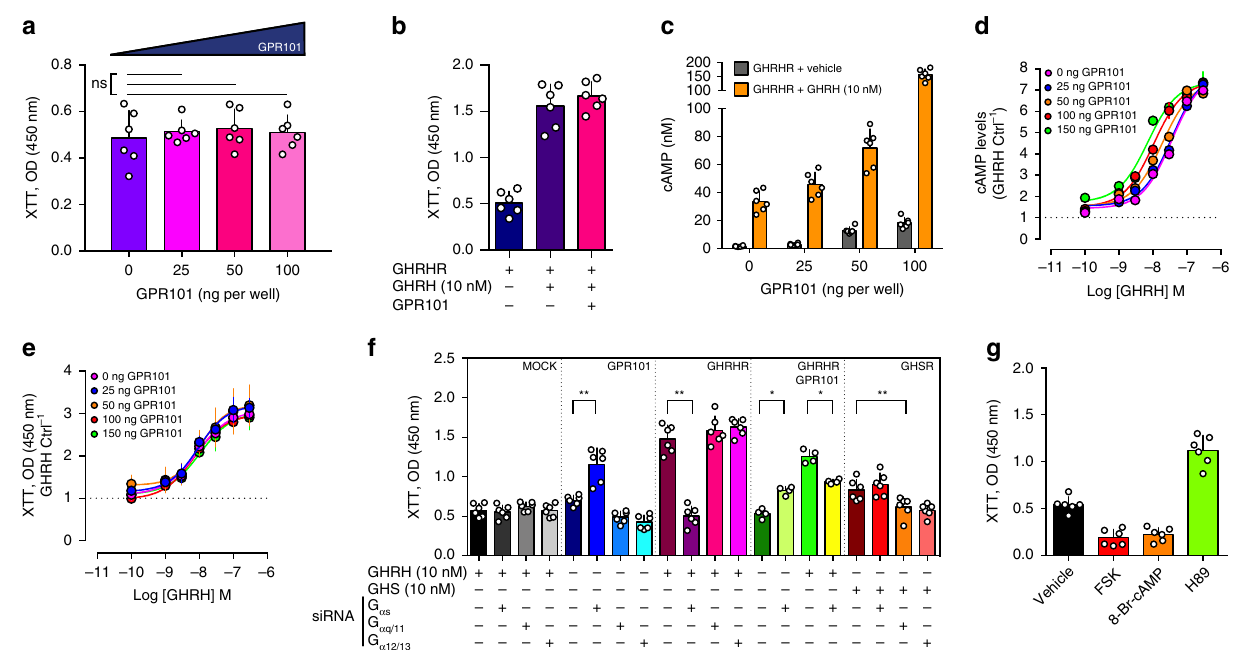
Fig. 6 GPR101 does not increase GH3 cell proliferation. a Proliferation was measured with XTT cell proliferation kit on GH3 cells transiently transfected with increasing amounts (0, 25, 50, and 100 ng) of pcDNA3.1 FLAG-GPR101 plasmid (0 ng vs 25 ng p = 0.8182; vs 50 ng p = 0.5887; vs 100 ng p = 0.6991 ) . b Quanti fi cation of proliferation (by using the XTT reagent) of GH3 cells co-transfected with GHRHR and GPR101 (or MOCK) and treated with vehicle or GHRH at fi nal concentration of 10 nM. c Comparison of cAMP levels (measured by ELISA) in GH3 cells transfected with GHRHR (100 ng) in the presence of increasing amounts (0, 25, 50, and 100 ng) of GPR101 plasmids, and treated with vehicle (dark grey) or GHRH (10 nM, orange). d , e GH3 cells transfected with GHRHR (100 ng) and increasing amounts of FLAG-GPR101. The cells were treated with increasing concentration of GHRH. d cAMP levels measured by ELISA and normalized to vehicle condition. e Proliferation measured with XTT assay. f Effect of the siRNA-mediated depletion of different G protein α subunits (G α s , G α q/11 , or G α 12/13 ) on GH3 proliferation measured Brie fl y, GH3 cells were incubated with siRNAs (G α s , G α q/11 , or G α 12/13 , at a fi nal concentration of 1 µ M) for 24 h, and then transfected with MOCK, GPR101 (NTS vs G α s p = 0.0022), GHRHR (NTS vs G α s p = 0.0022), GPR101 + GHRHR (untreated NTS vs G α s p = 0.0286, GHRH-treated NTS vs G α s p = 0.0286) or GHSR (GHS-treated NTS vs G α q/11 p = 0.0065). GHRHR- and GPR101 + GHRHR-transfected cells were stimulated with GHRH (10 nM) and GHSR-transfected cells with GHS (10 nM). g Determination of the proliferation of GPR101-transfected GH3 cells treated with vehicle or different pharmacological agents, such as FSK (adenylate cyclase activator, 10 µ M), 8-Br-cAMP (PKA activator, 10 µ M), and H89 (PKA inhibitor, 10 µ M). All data are Mean± S.D. of n = 6 independent experiments (except for the co-transfection of GHRHR with GPR101 in panel f and for experiments of panels d , e where n = 4). For statistical analysis of all data, a two-sided Mann – Whitney test was used. ns